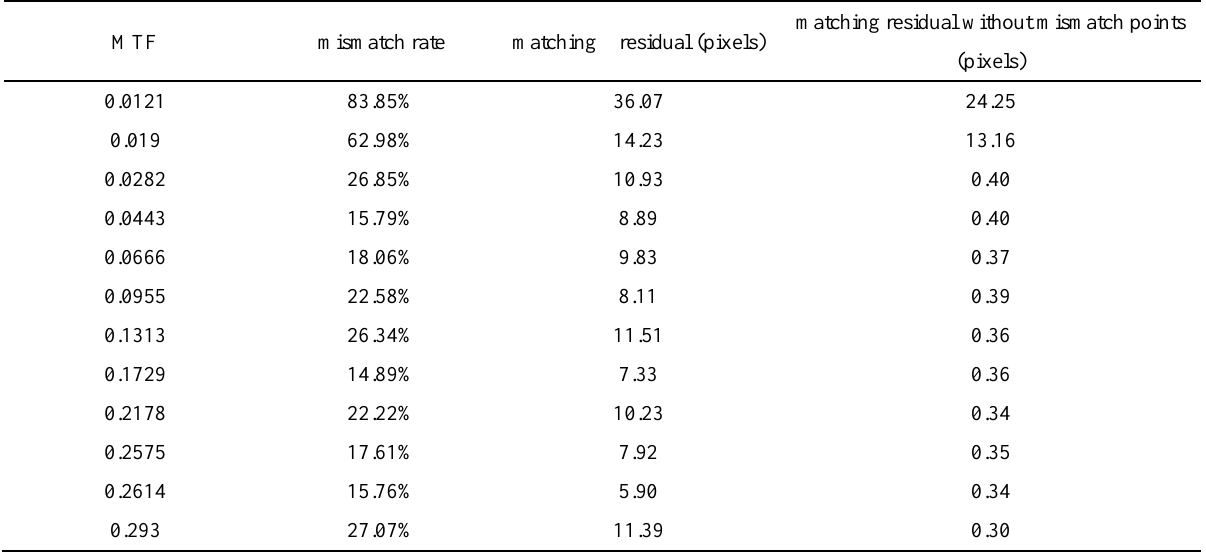
Table 4. the mismatch rate, matching residual and matching residual without mismatch points with different MTF of the first simulated